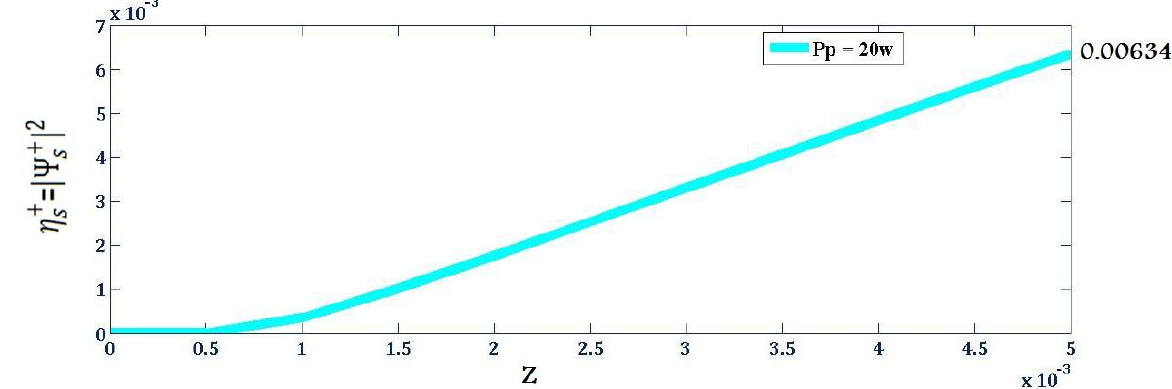
Figure 2. Efficacy of forward second harmonic beam in z-direction (path length).